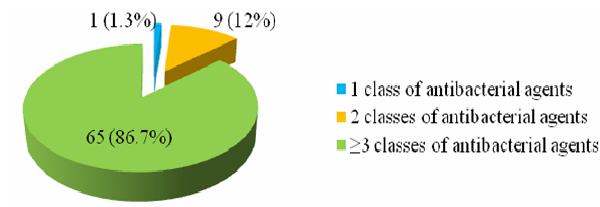
Fig. 3. Number of antibacterial classes to which 75 enterococcal isolates from beef cattle were resistant